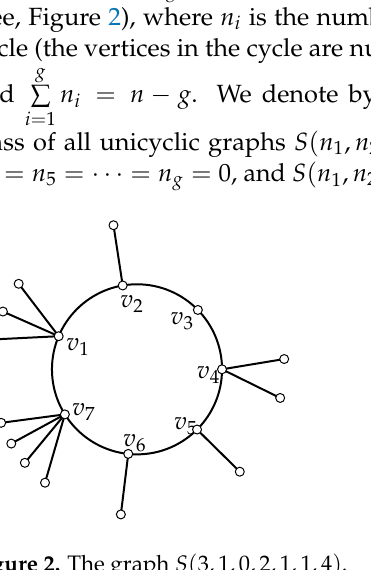
Figure 2. The graph S ( 3,1,0,2,1,1,4 )